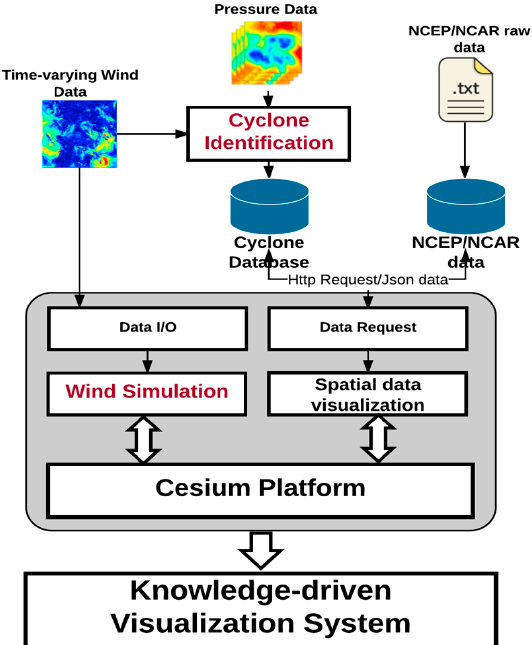
Figure 2. The system architecture of the web-based knowledge-driven visualization system.